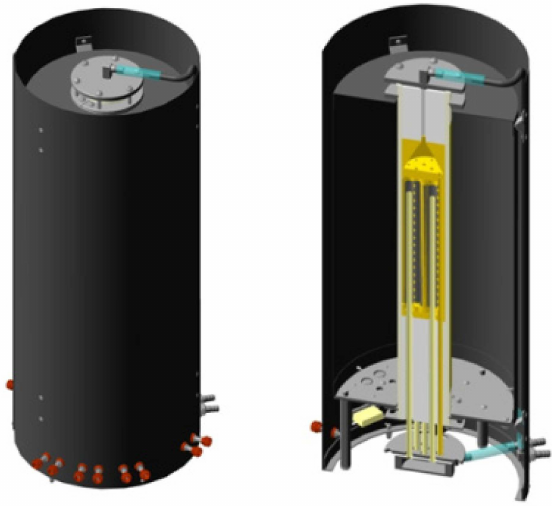
Figure 17. Appearance and internal structure of a solid-oxide fuel